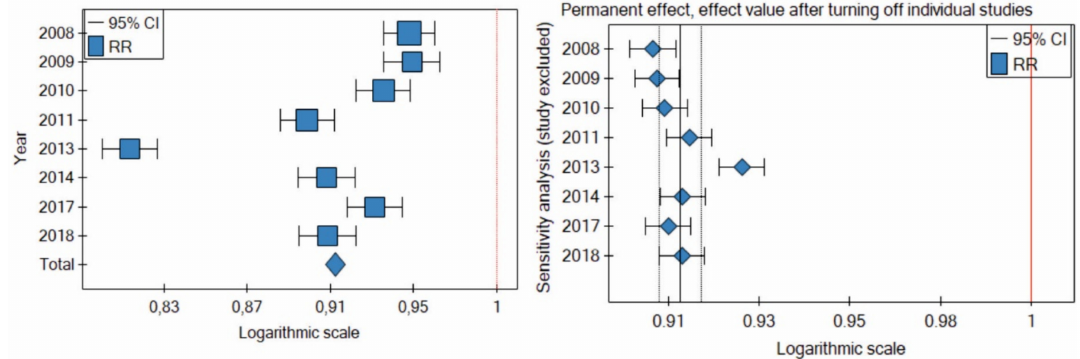
Figure 5. The relative risk of an accident at work among workers aged 40–49 years employed in Poland (own elaboration).